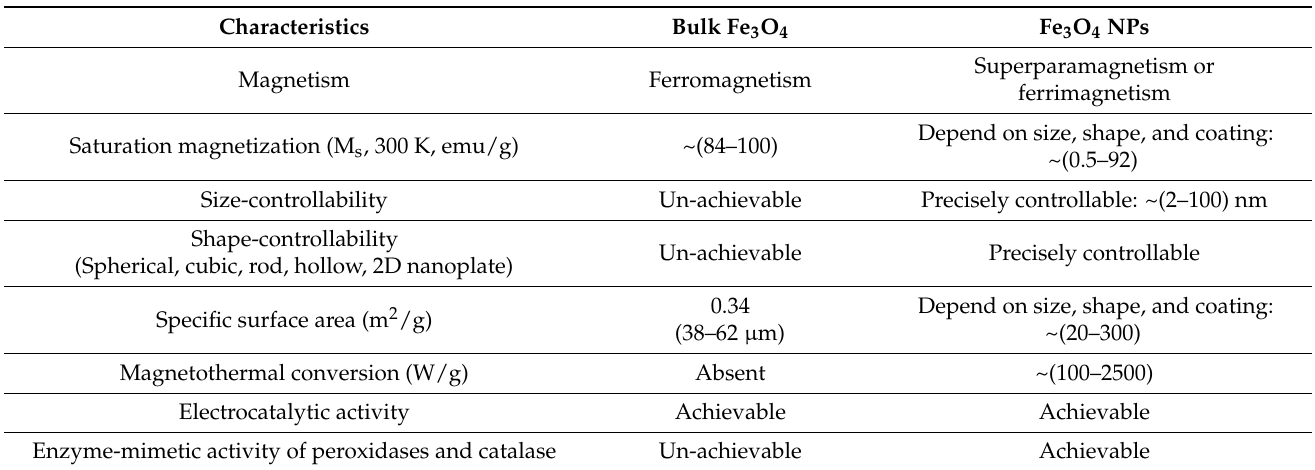
Table 1. Characteristics of bulk Fe 3 O 4 and Fe 3 O 4 NPs